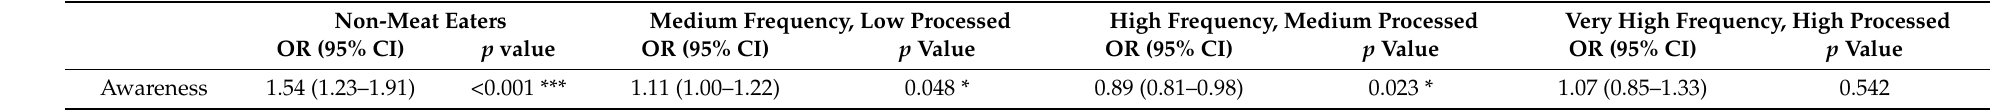
Table 4. Participants’ awareness about the term cultured meat.